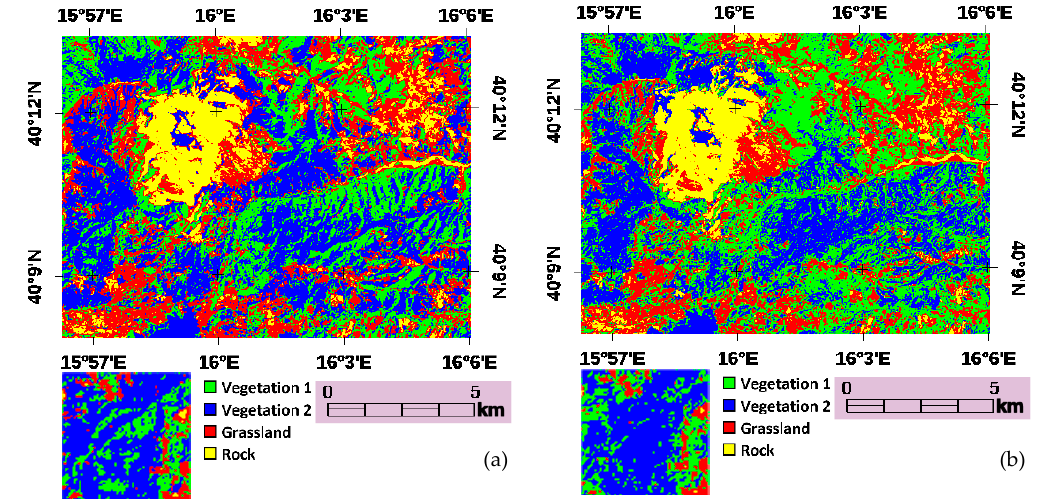
Figure 9. K-means maps obtained by setting four classes and a maximum of 100 iterations before ( a ) and after ( b ) topographic corrections.